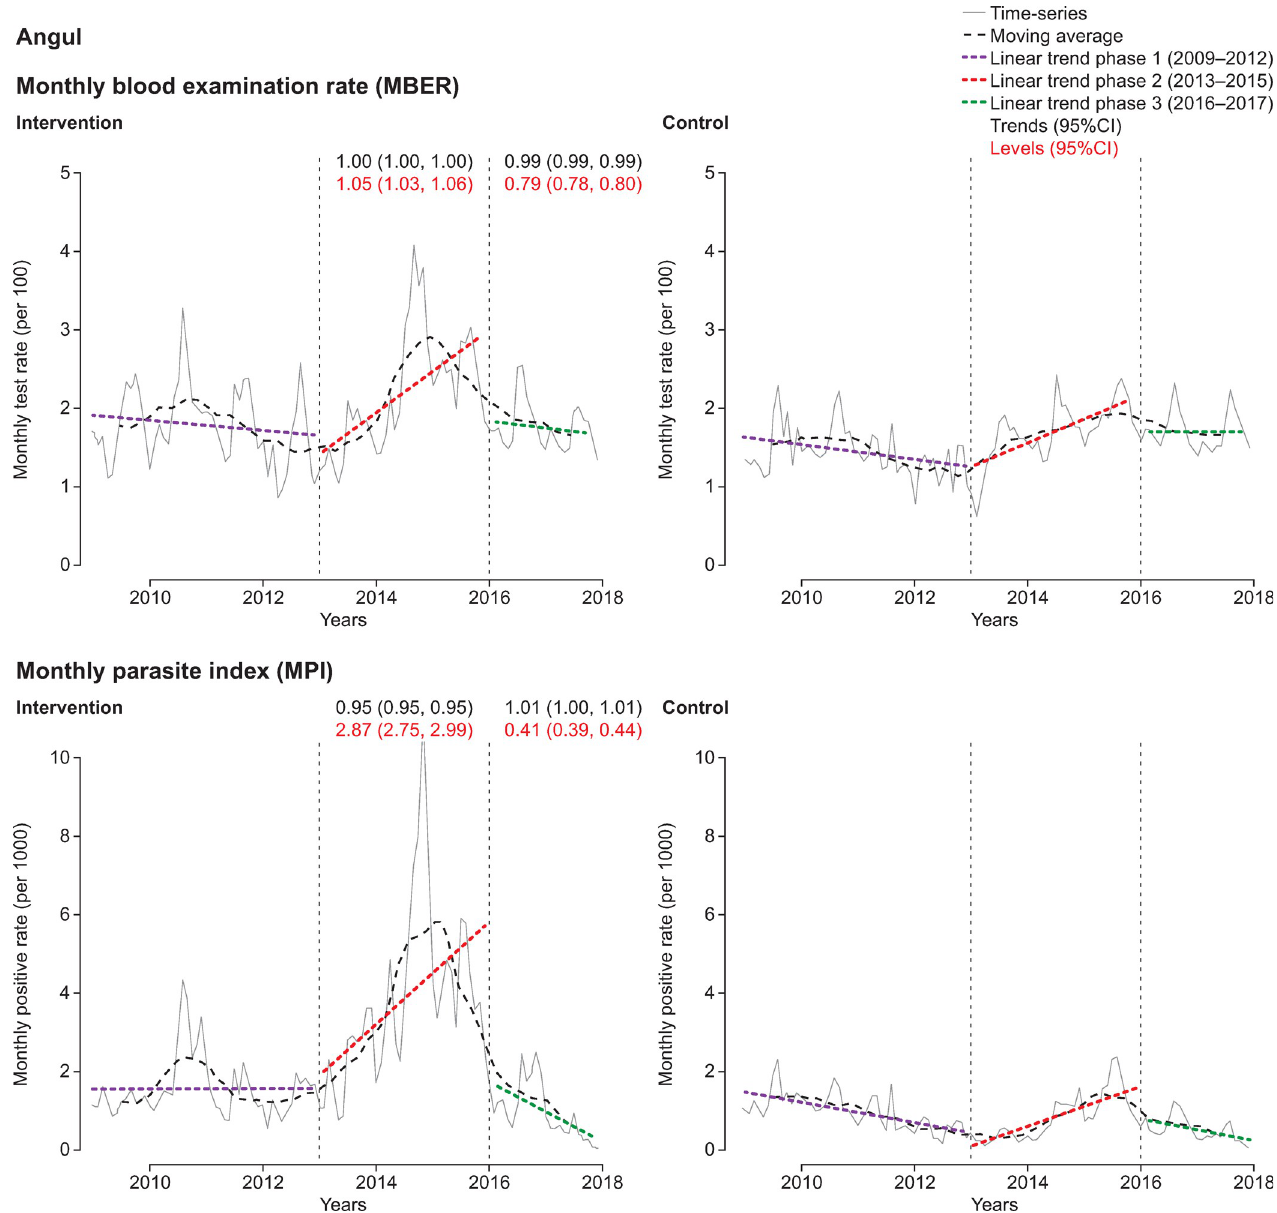
Fig 6. Interrupted time-series analysis of changes in malaria indices for Angul. MBER, monthly blood examination rate = total number of slides examined in a month x1000 / total population; MPI, monthly parasite index = total number of positive slides for parasite in a month x1000 / total population.